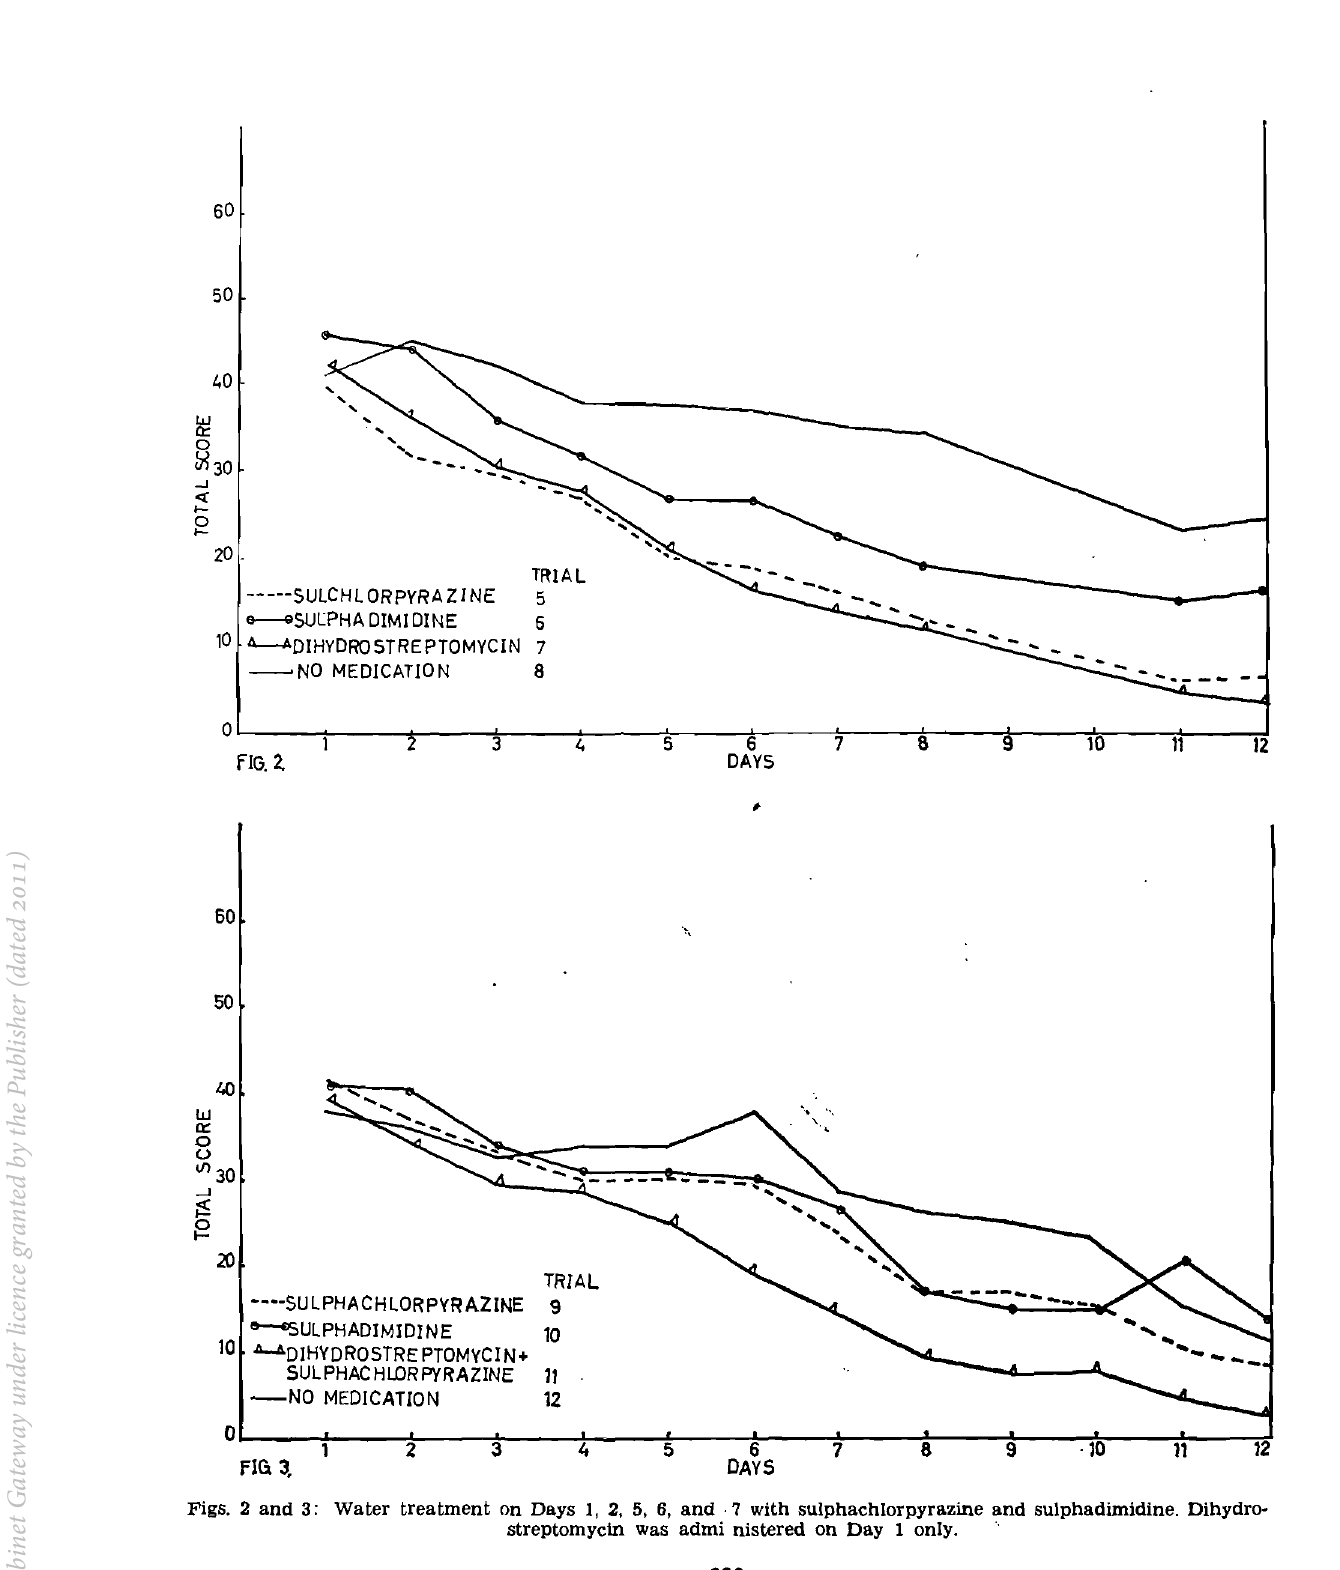
Figs. 2 and 3: Water treatment on Days 1, 2, 5, 6, and· 7 with sulphachlorpyrazine and sulphadimidine. Dihydro streptomycin was admi nistered on Day 1